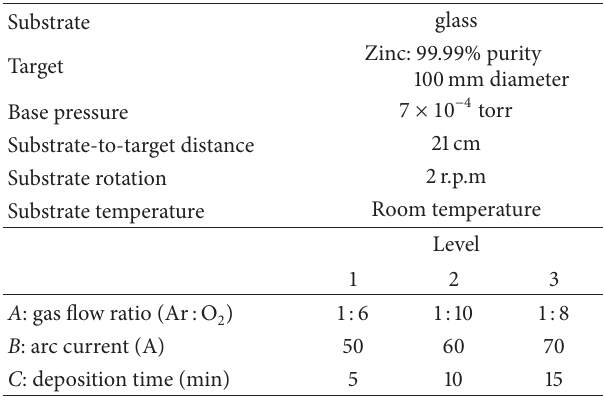
Table1:DepositionparametersofZnOfilmsfactorsandlevelsusing cathode arc plasma deposition